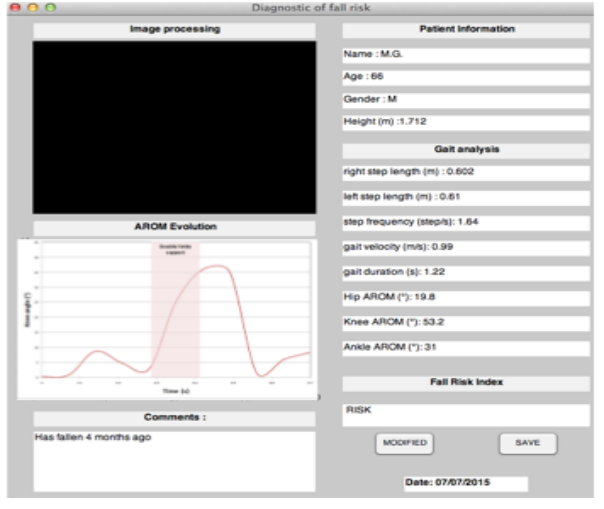
Figure 8: Fuzzy logic